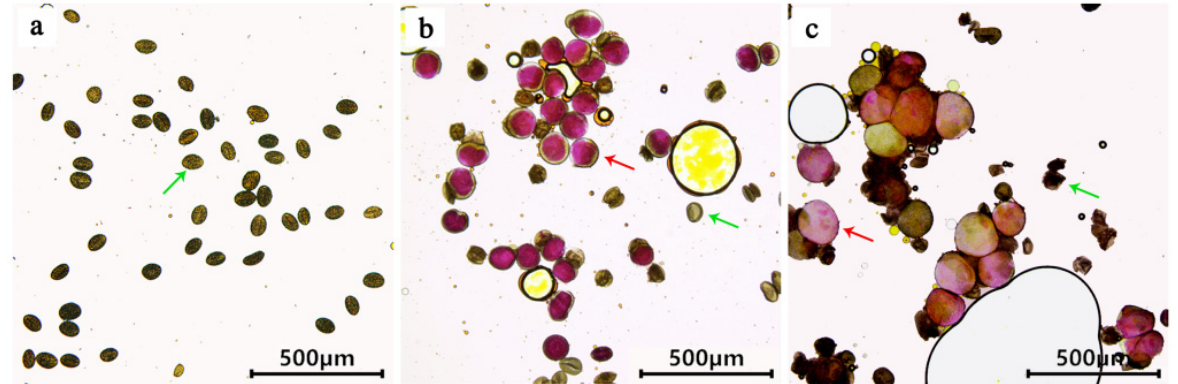
Figure 4. Comparison of sterile and fertile pollen from ‘Black Beauty’. ( a ) Control group. ( b ) Pollen grains obtained after 4 h treatment at 42 °C. ( c ) Pollen grains obtained after 6 h treatment at 42 °C. (Nonfertile pollen indicated by green arrows, and fertile pollen indicated by red arrows).